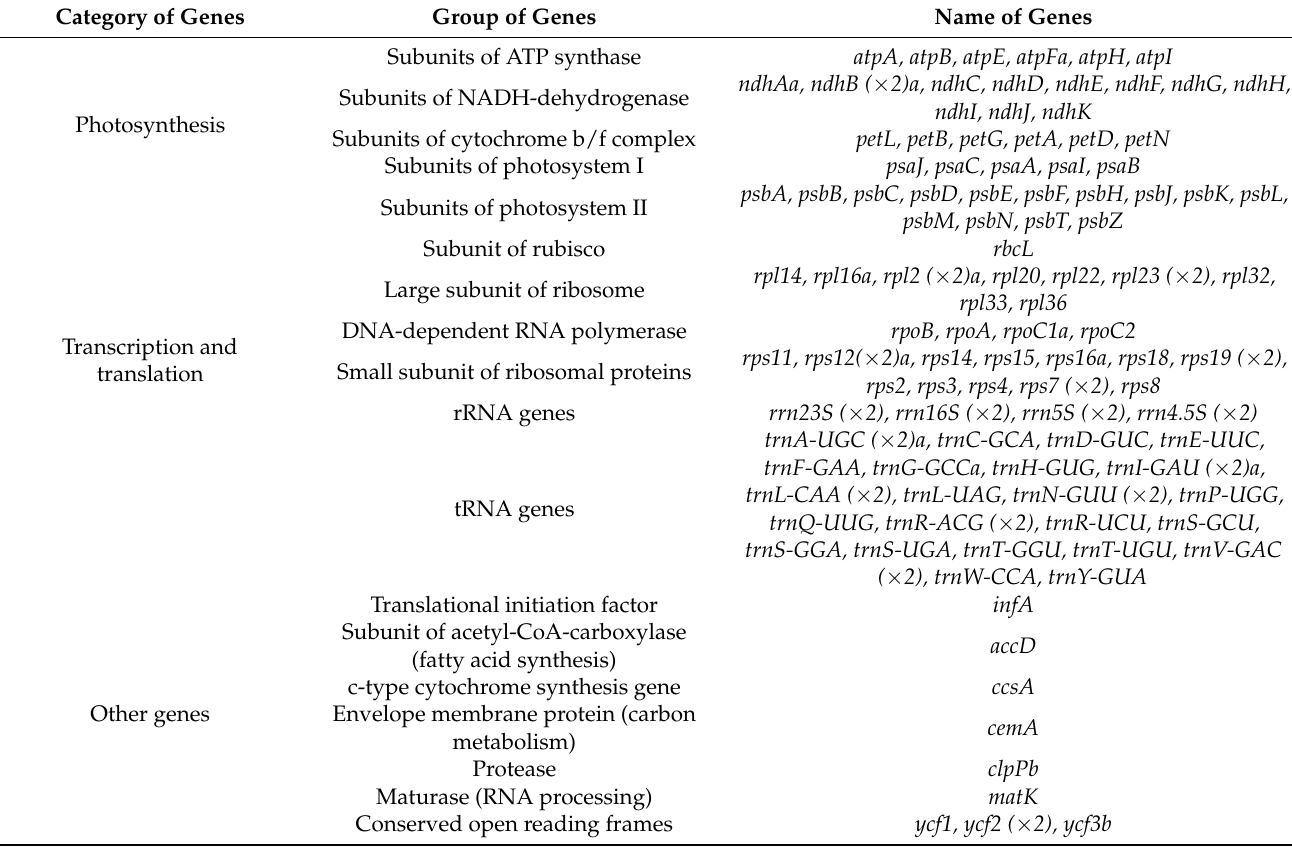
Table 2. Gene composition of O. baviensis Drake chloroplast